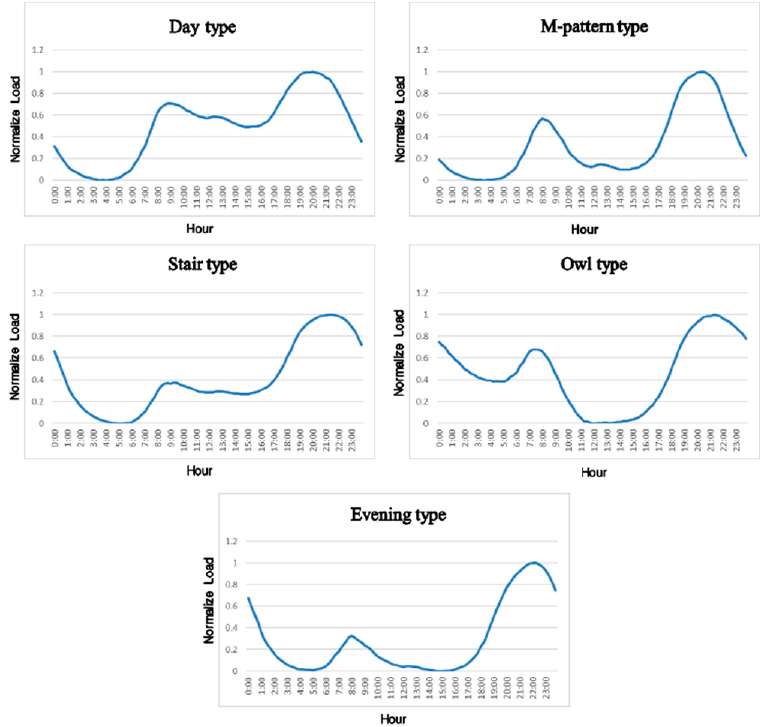
Figure 4. Results of five residential customer clustering utilizing K-means.